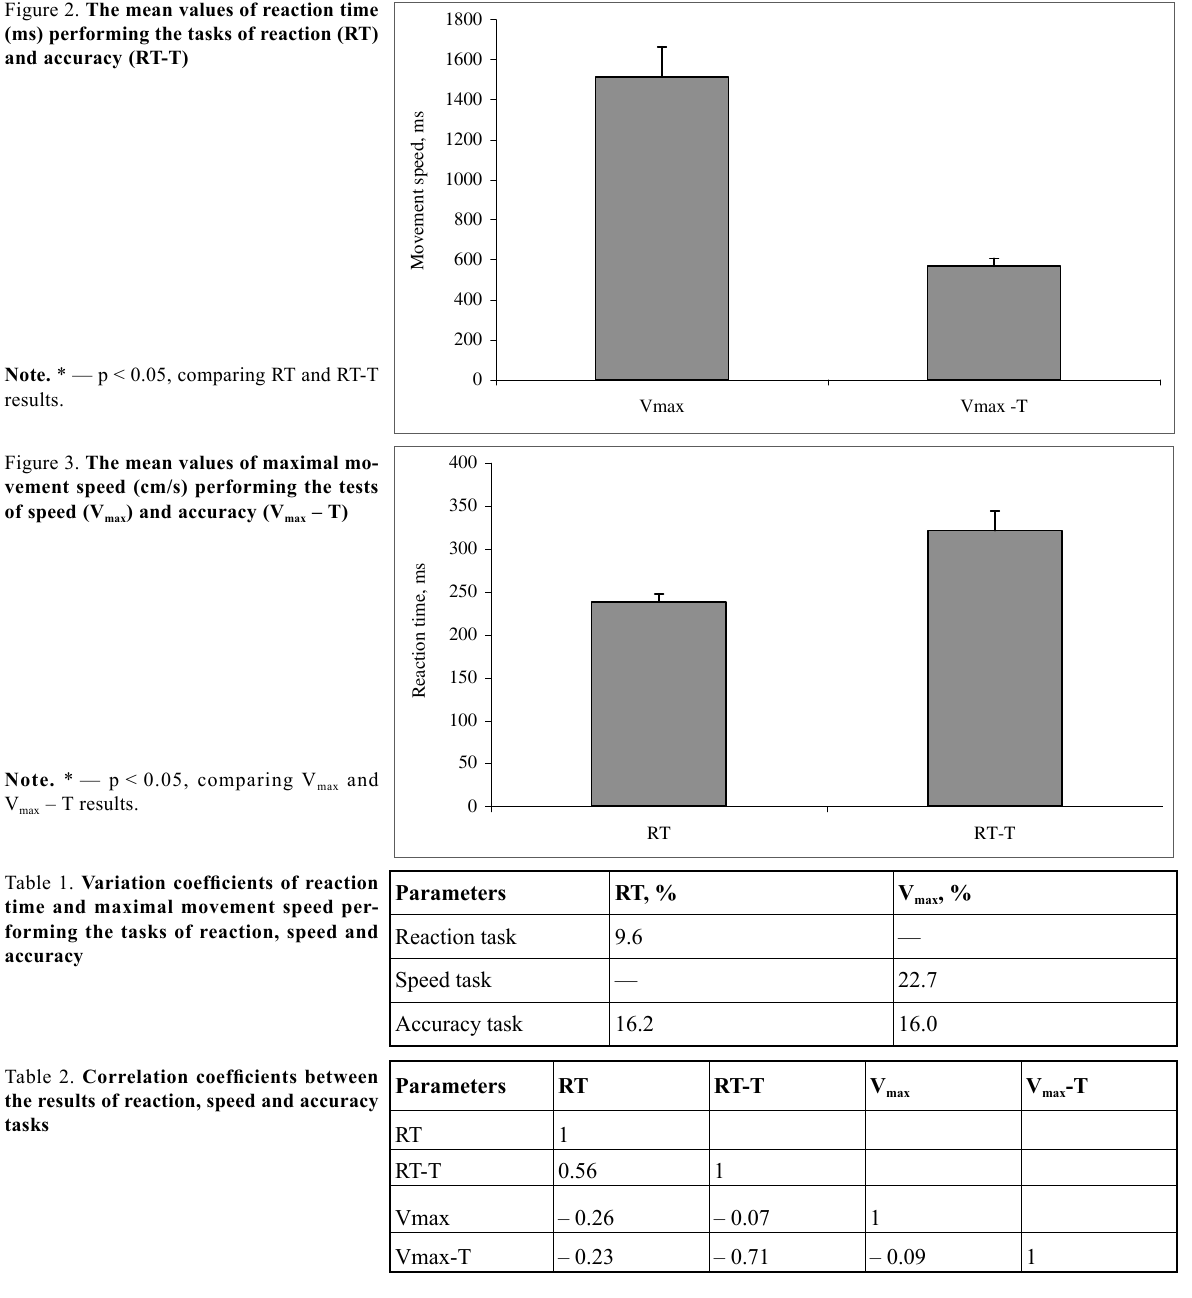
Table 2. Correlation coef fi cients between the results of reaction, speed and accuracy